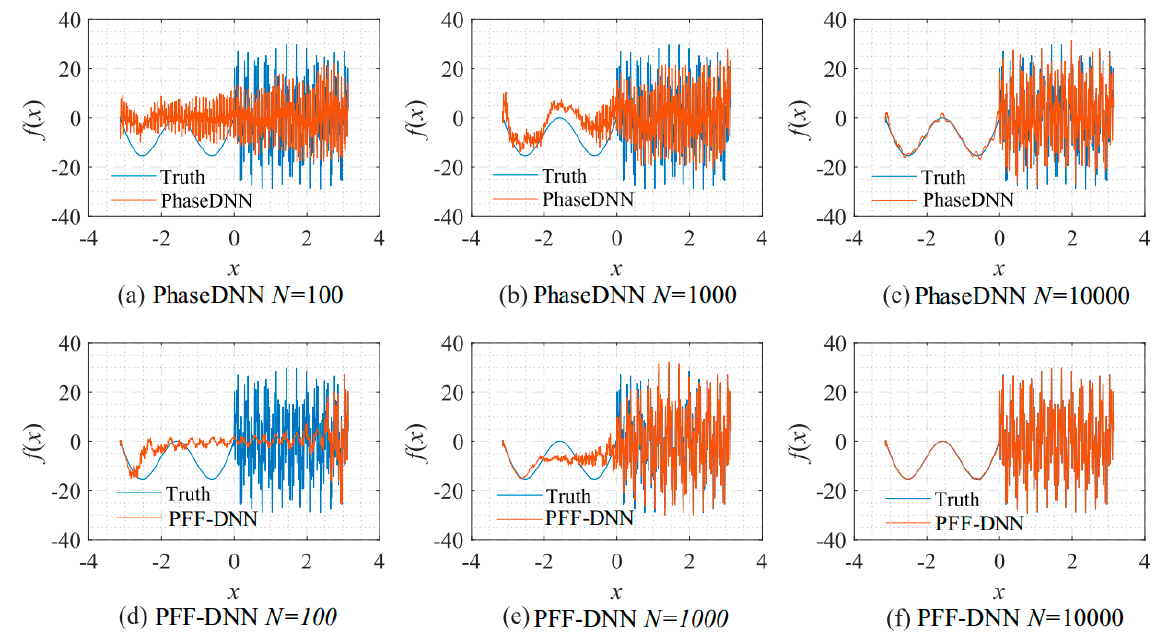
Figure 21. The influence of N on the algorithm performance. Fitting results of the PhaseDNN method when Δ ω = 11: ( a ) N = 100; ( b ) N = 1000; and ( c ) N = 10,000. Fitting results of the PFF-DNN method when Δ ω = 11: ( d ) N = 100; ( e ) N = 1000; and ( f ) N = 10,000.